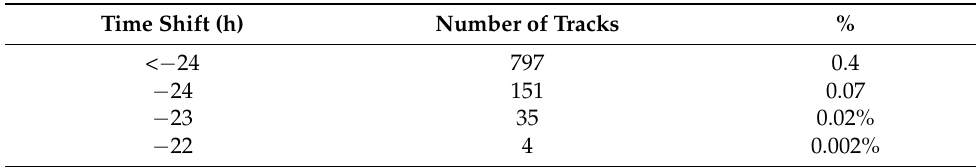
Table 13. Time shift (in hour) between record_utc and time_location , for the tracks are are 100%